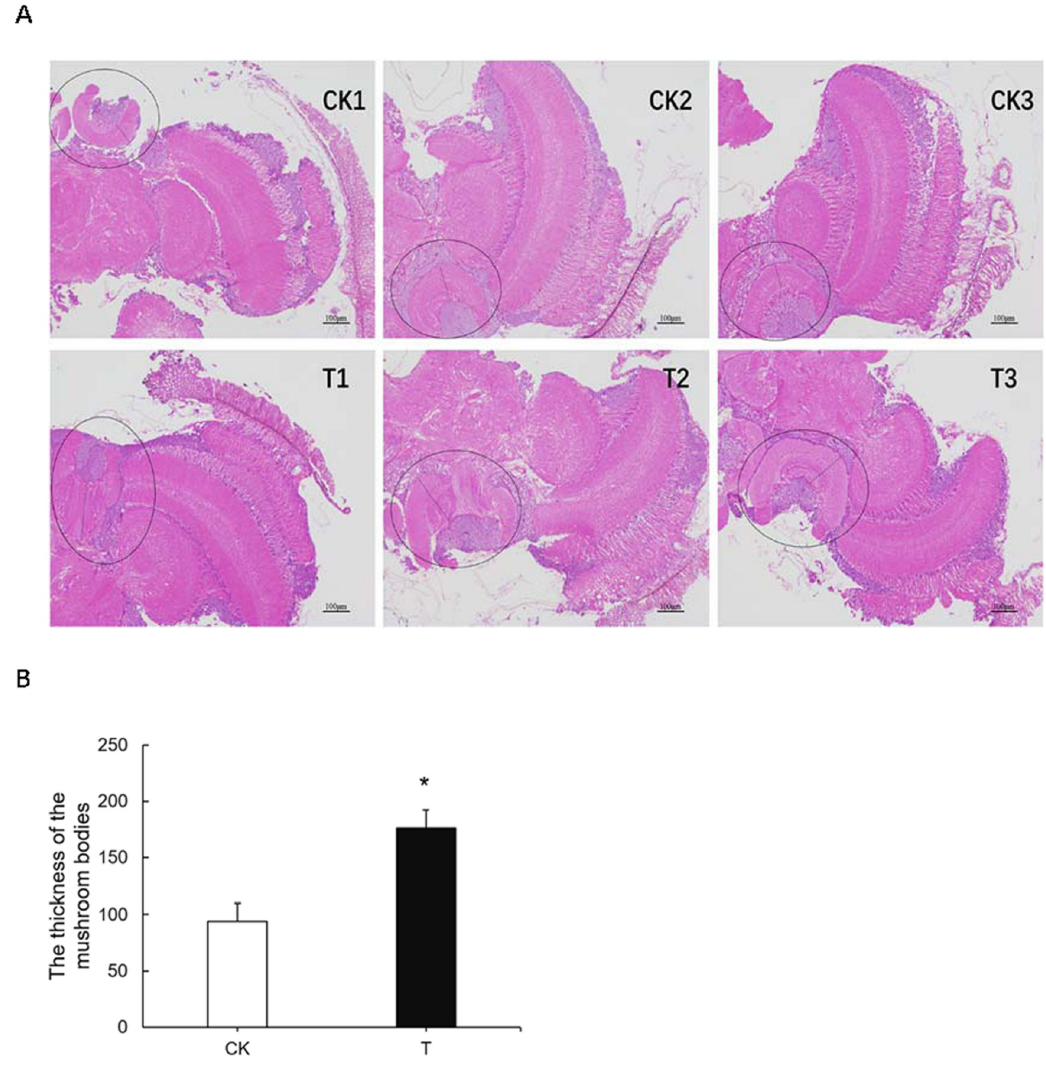
Fig 8. The effect of T . mercedesae infestation on mushroom body in the brain of adult honey bees. A. Photomicrographs of sections of mushroom body of control worker bees and T . mercedesae infested bees stained with hematoxylin and eosin. The black circle was indicated mushroom body of individual honeybee. B. The thickness of mushroom bodies of control bees and T . mercedesae infested bees. Data are means of three biological replicates, and error bars represent ± standard error (SE) (n = 3). Significant differences to CK with P < 0.05 are indicated by an asterisk above the bars and were determined by one-way ANOVA followed by Tukey’s